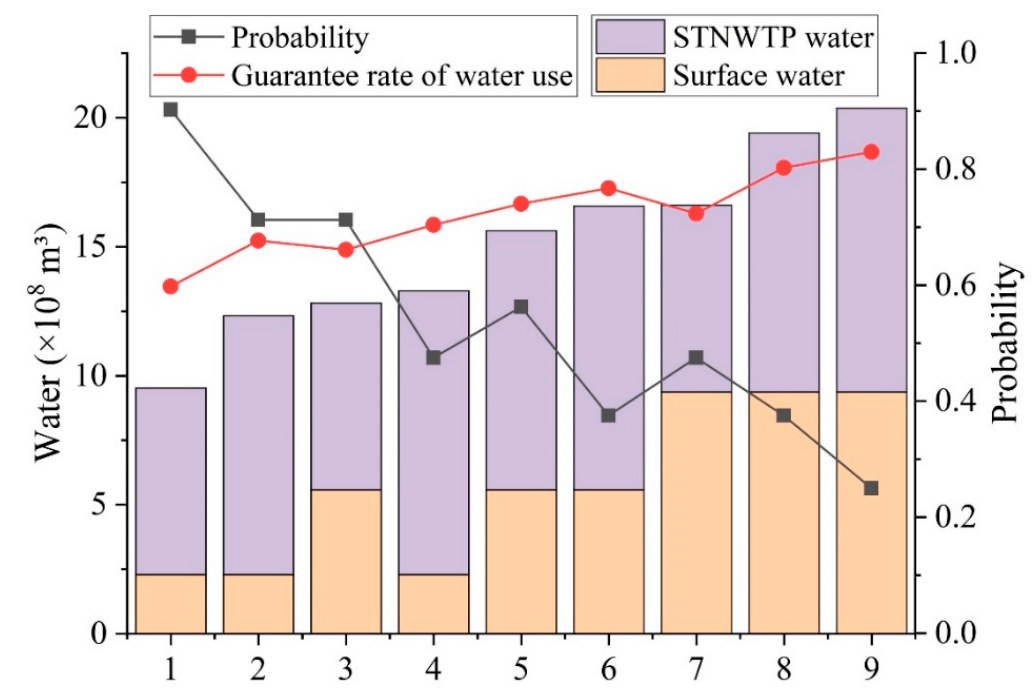
Figure 4. Nine schemes when the STNWTP is the only external water source.